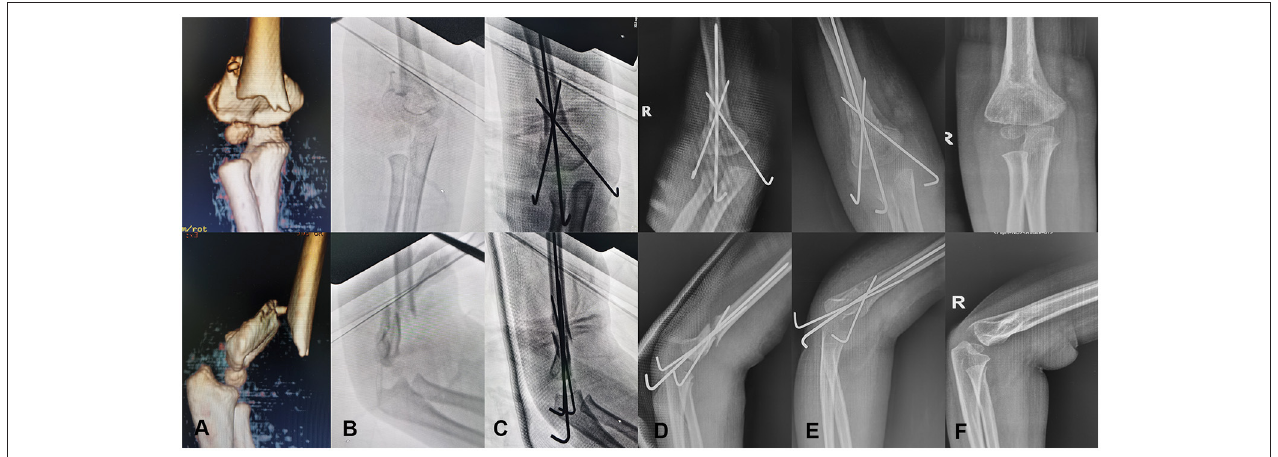
FIGURE 2 | A 4-year-old boy with displaced MDJ fracture of his right elbow. (A) The coronal and sagittal 3D-CT images of the fracture; (B) the AP and lateral radiographs of the fracture before intraoperative reduction; (C) the AP and lateral radiographs after the utilization of the novel CRPP procedure intraoperatively; (D) the AP and lateral radiographs at 1 day after surgery; (E) the AP and lateral radiographs at the time of pin removal 4 weeks post-operatively; (F) the AP and lateral radiographs at 12 months post-operative follow-up.